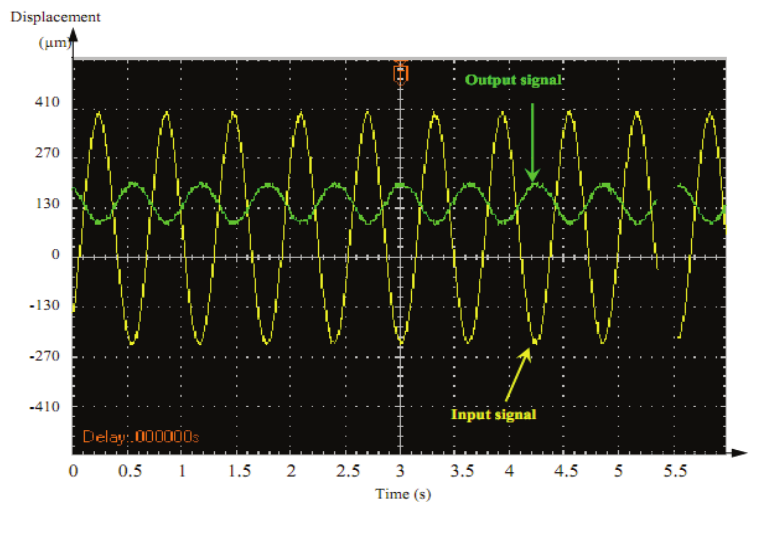
Figure 15. Sine-wave signal.